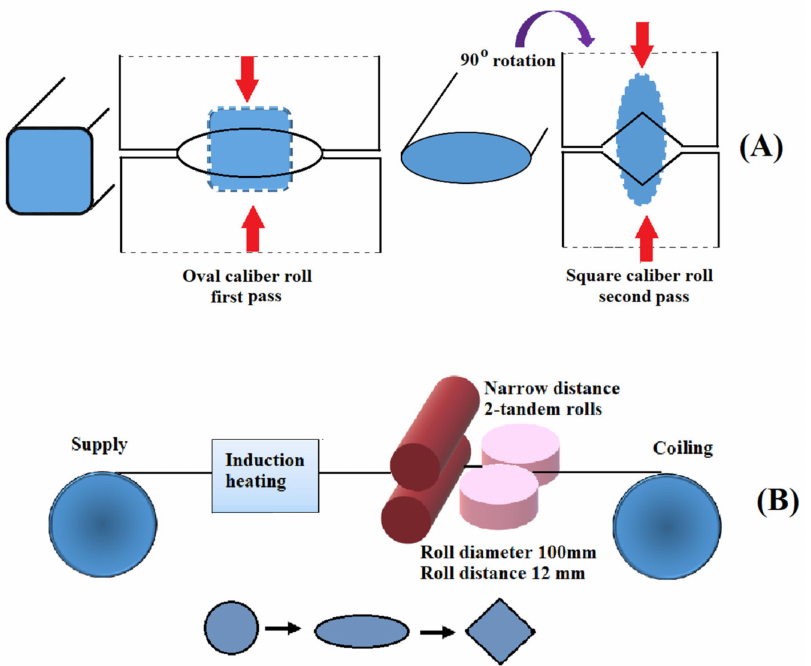
Figure 7. Schematic drawing of multidirectional deformation rolling realized using an oval-caliber and square-caliber rolling ( A ); redrawn from [60]. A schematic illustration of a novel advanced warm continuous oval- to square-rolling set-up ( B ); reproduced from [60], with permission from Elsevier,